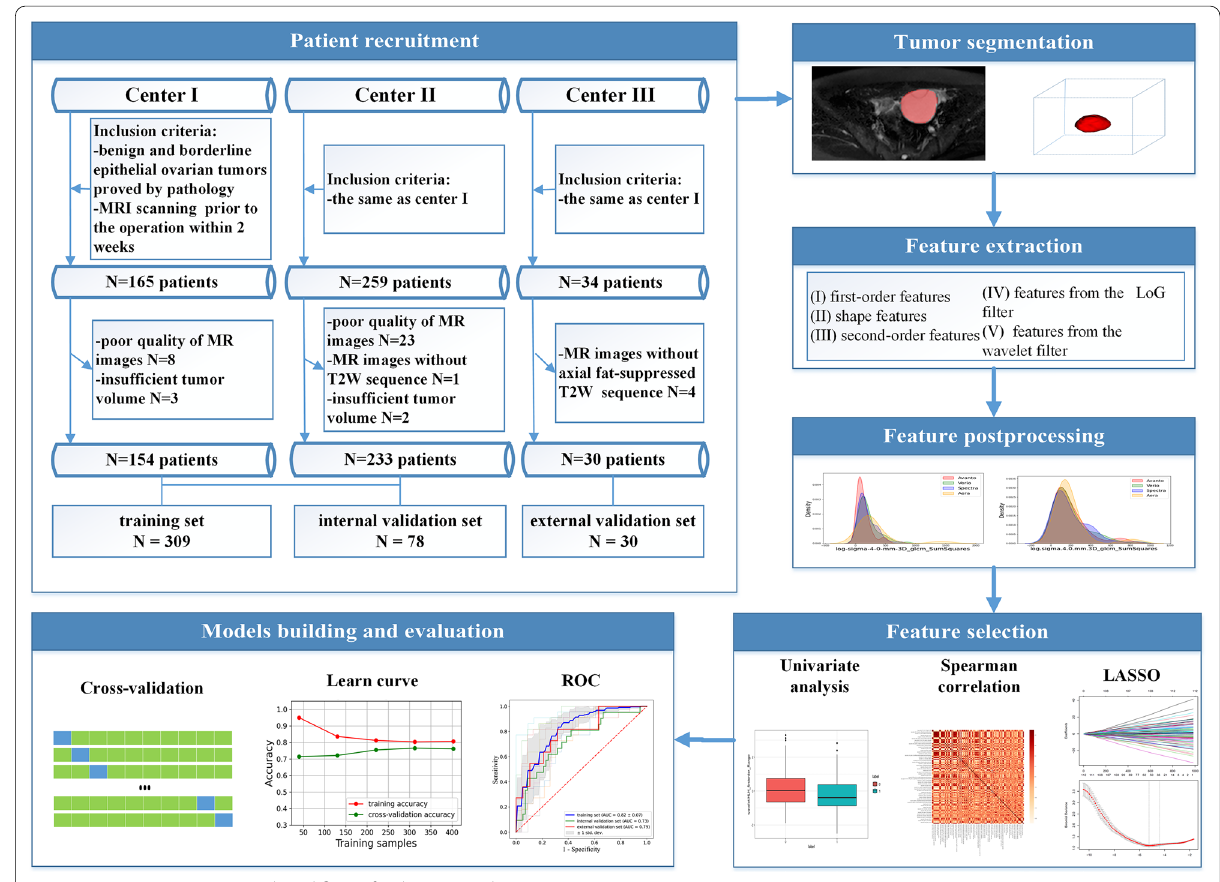
Fig. 1 Patient recruitment and workflow of radiomics